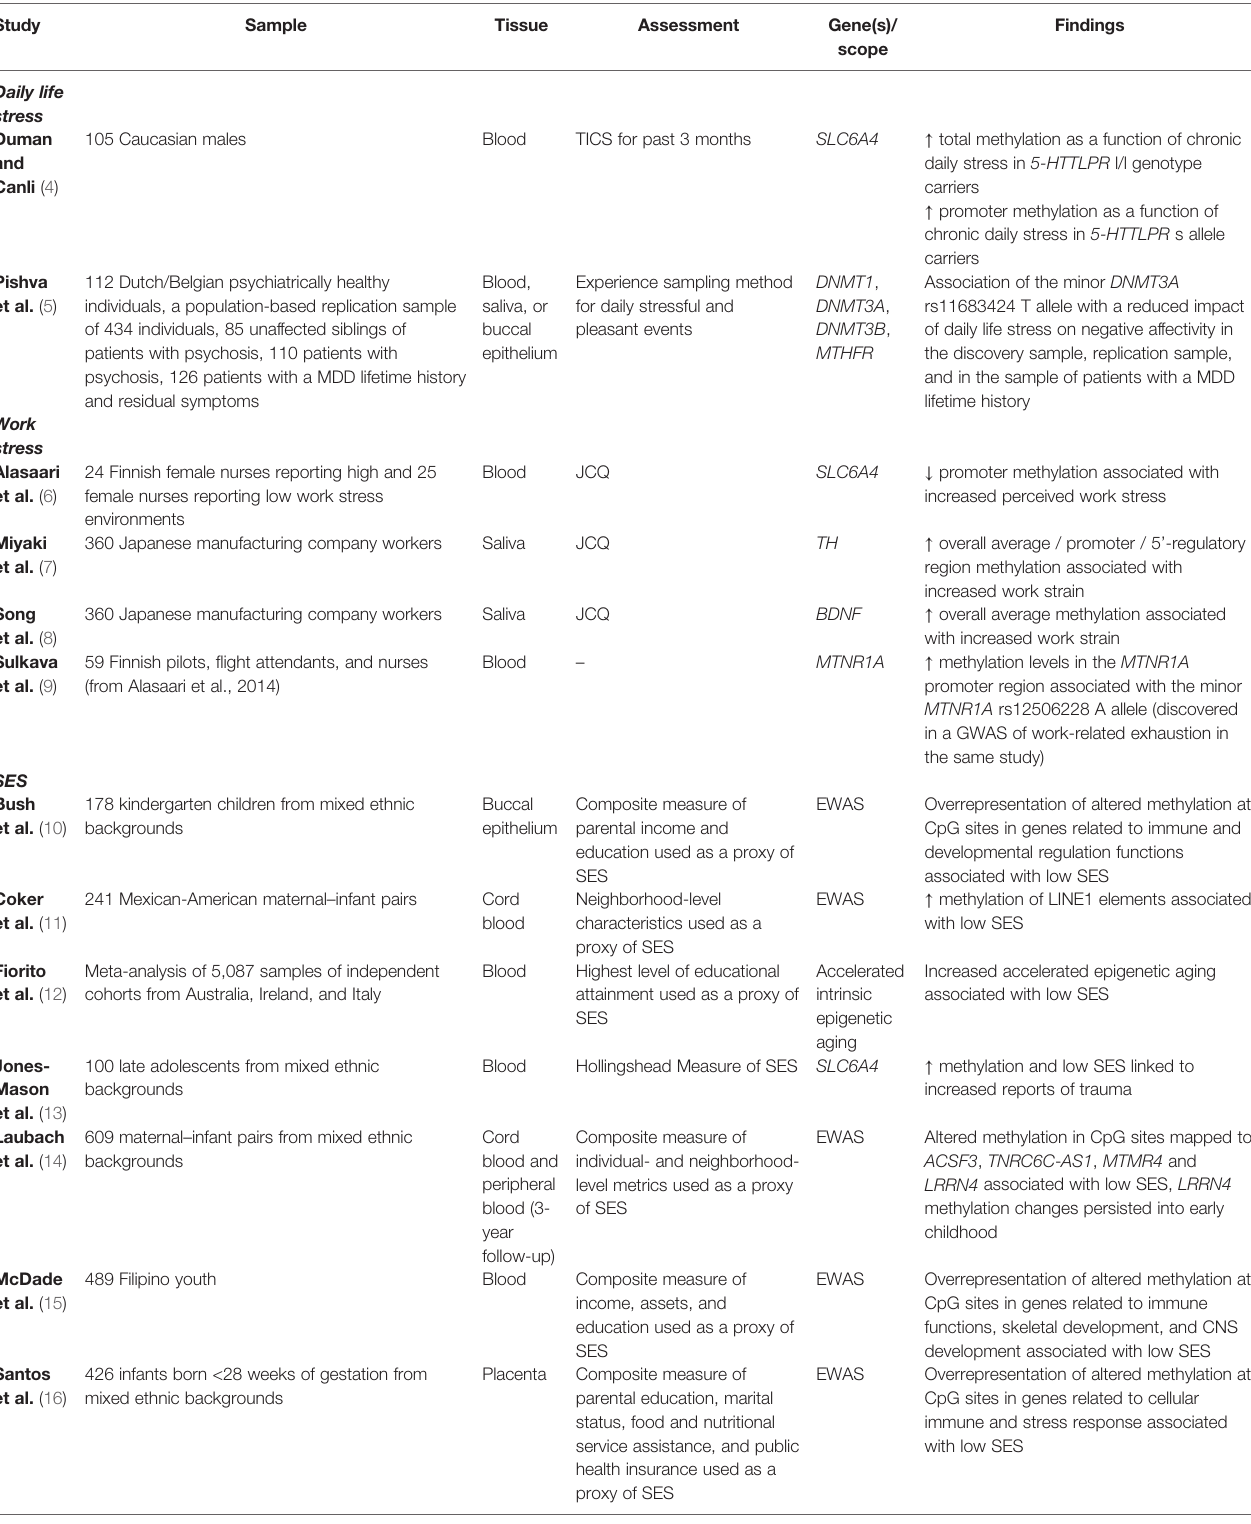
TABLE 1 | Overview of epigenetic studies relating to daily life stress, work stress, and socioeconomic